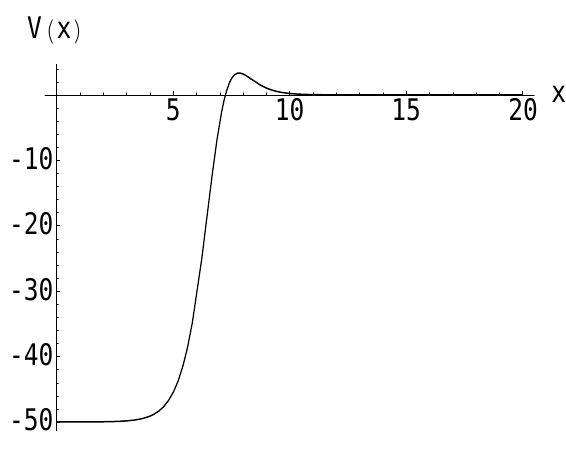
Figure 4. The Woods–Saxon